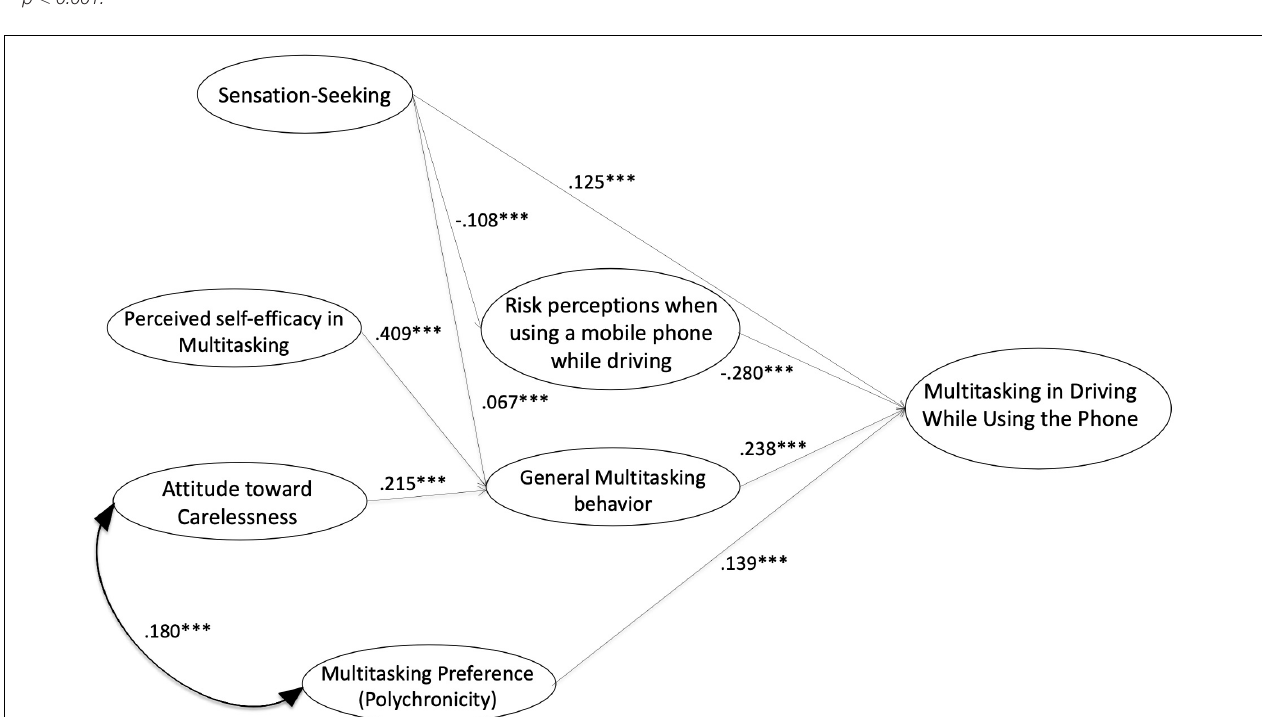
FIGURE 1 | Standardized path coefficients of structural model for Multitasking in driving using the phone. ∗∗∗ p < 0.001.